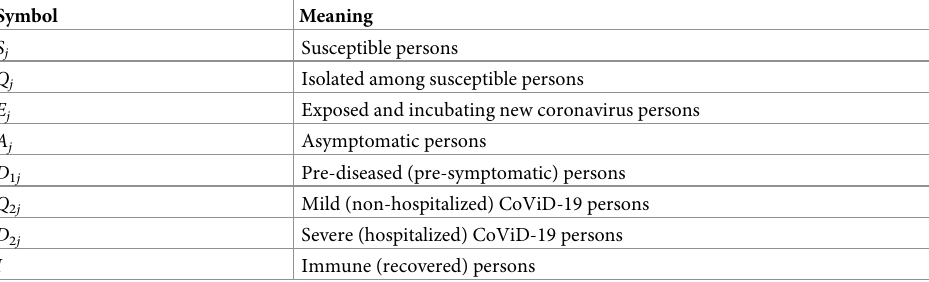
Table 1. Summary of the model variables ( j = y , o